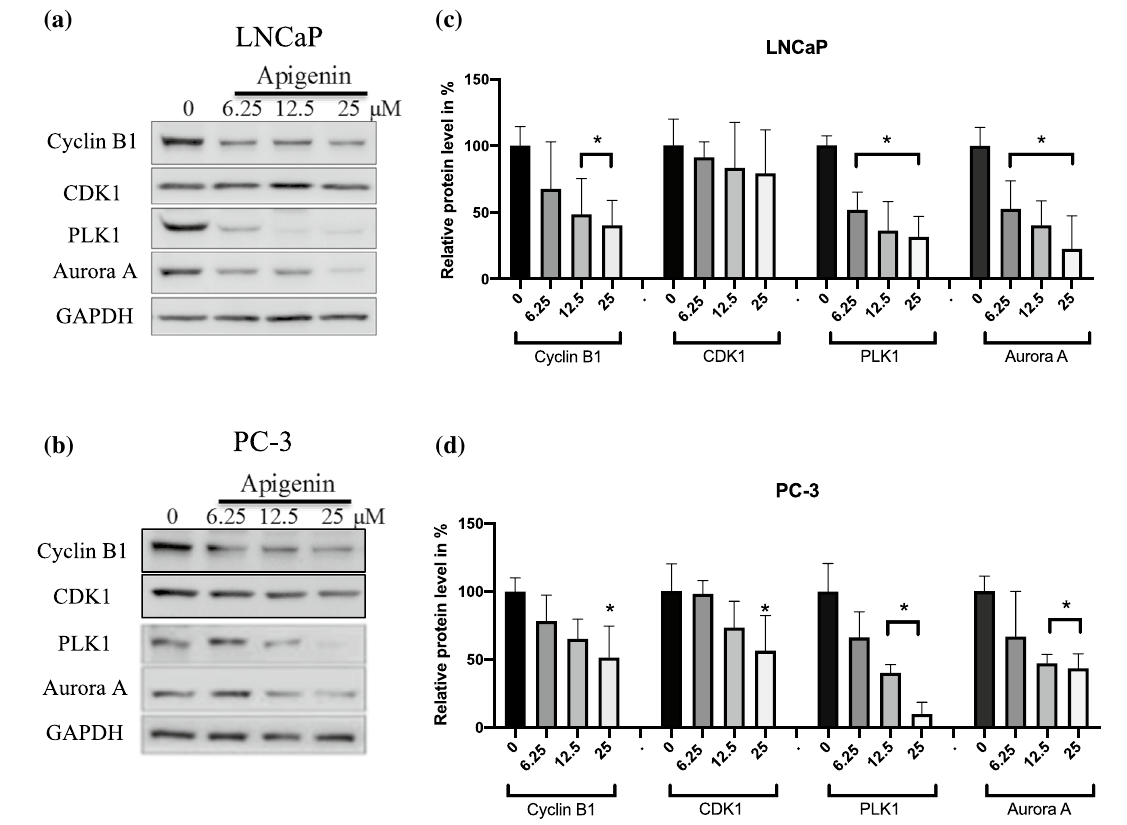
Fig. 4 Apigenin down-regulated the regulators governing G to M transition at protein levels in prostate cancer cells. a LNCaP and b PC-3 2 cells were treated with a dose range of apigenin (0–25 µM) for 72 h and harvested for immunoblotting. The protein levels were quantified using Bio-Rad image lab application and the data were shown as the mean ± SD from three different experiments, c and d . *p < 0.05 com- pared to